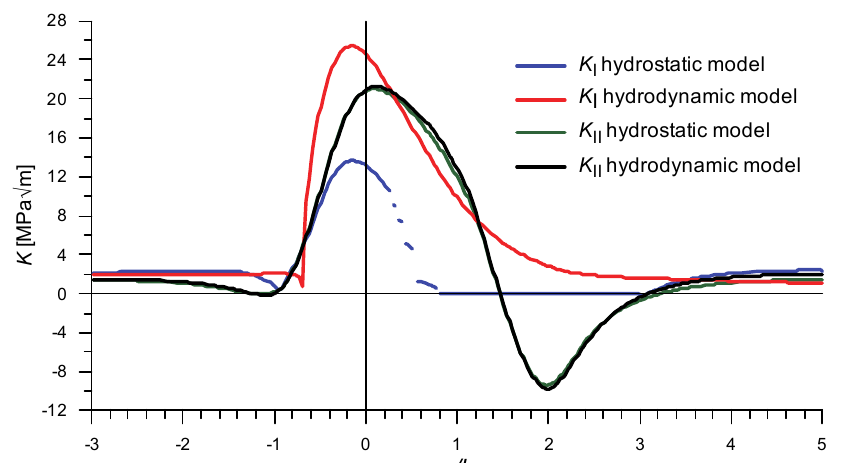
Figure 5: Distributions of the stress intensity factors in the process of cylinder rolling along a prism with the crack filled with viscous liquid (hydrodynamic model) and inviscid liquid (hydrostatic model),